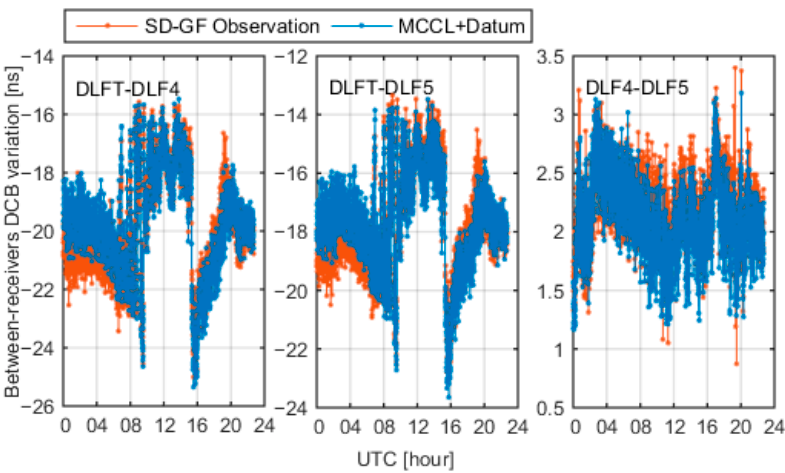
Figure 2. Epoch-by-epoch estimates of BR-DCB using SD-GF method (red line) and MCCL plus datum method (blue line) for three pairs of co-located receivers: DLFT-DLF4, DLFT-DLF5, DLF4-DLF5 on DOY 172, 2010.